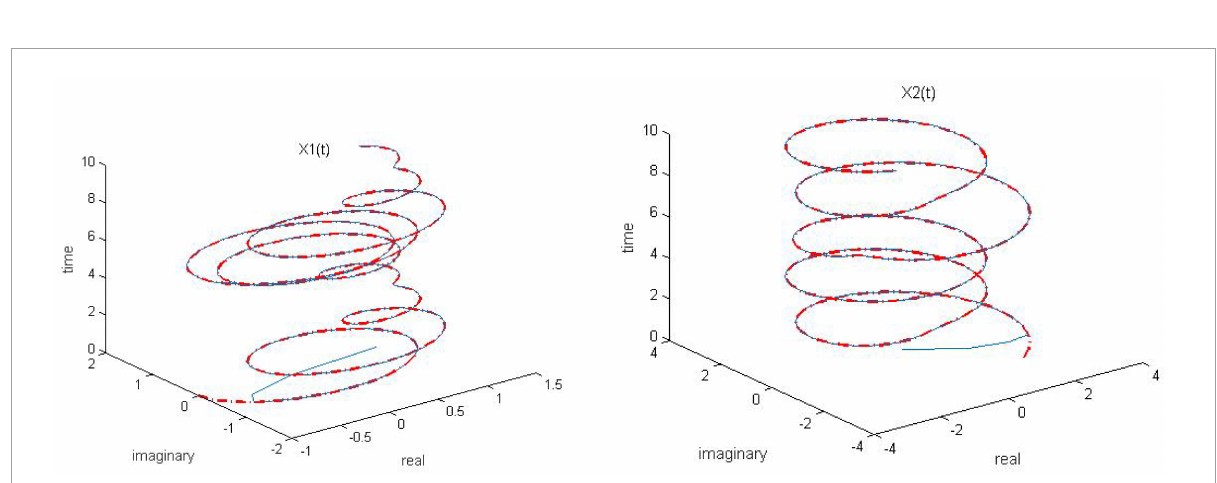
FIGURE3 Dynamic complex matrix equation (DCME) (1) solved by robust zeroing neural network (RZNN) model (10) with k = 2 in no noise